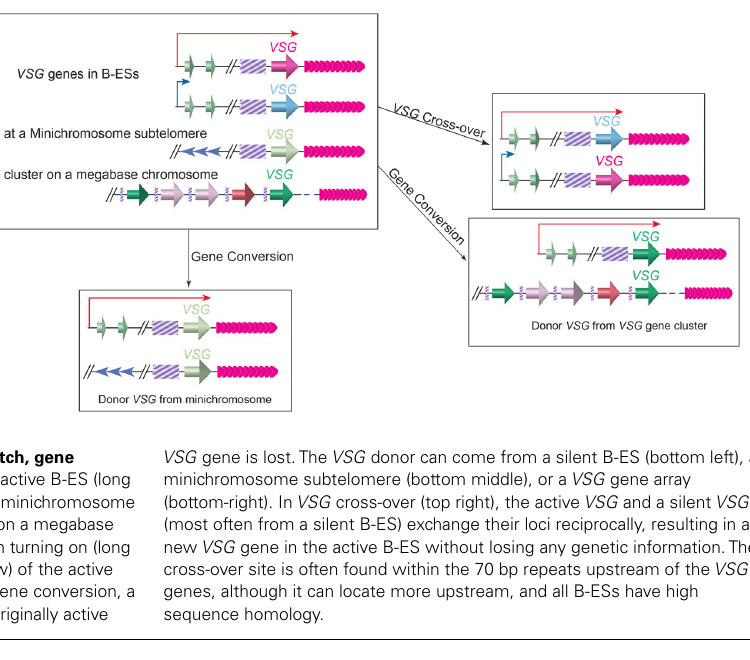
FIGURE 4 | VSG switching can occur through in situ switch, gene conversion, or crossover. Top Middle, before switching, an active B-ES (long red arrow), a silent B-ES (short blue arrow), a VSG gene at a minichromosome subtelomere, and an array of VSG genes and pseudogenes on a megabase chromosome are shown. In situ switch (top left) results from turning on (long blue arrow) of the silent B-ES and turning off (short red arrow) of the active B-ES simultaneously without any DNA rearrangements. In gene conversion, a silent VSG gene is duplicated into the active B-ES, and the originally active